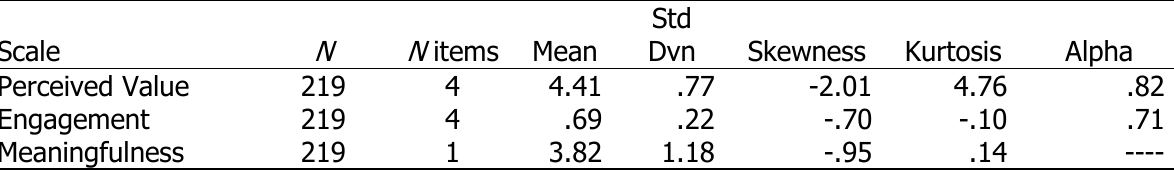
Central Tendency, Dispersion, and Shape of the Distributions of Perceived Value,